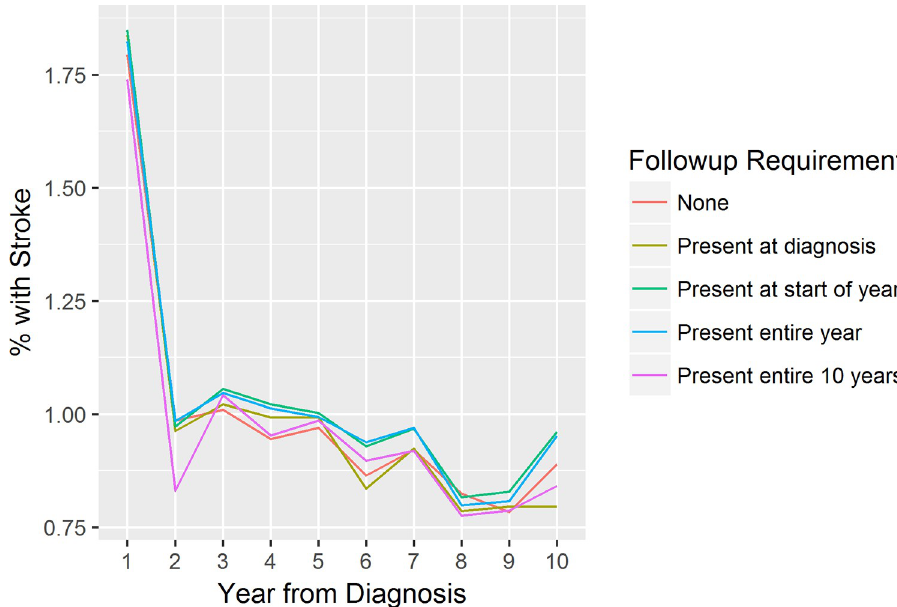
Fig 4. Measured incidence of stroke by year from AF